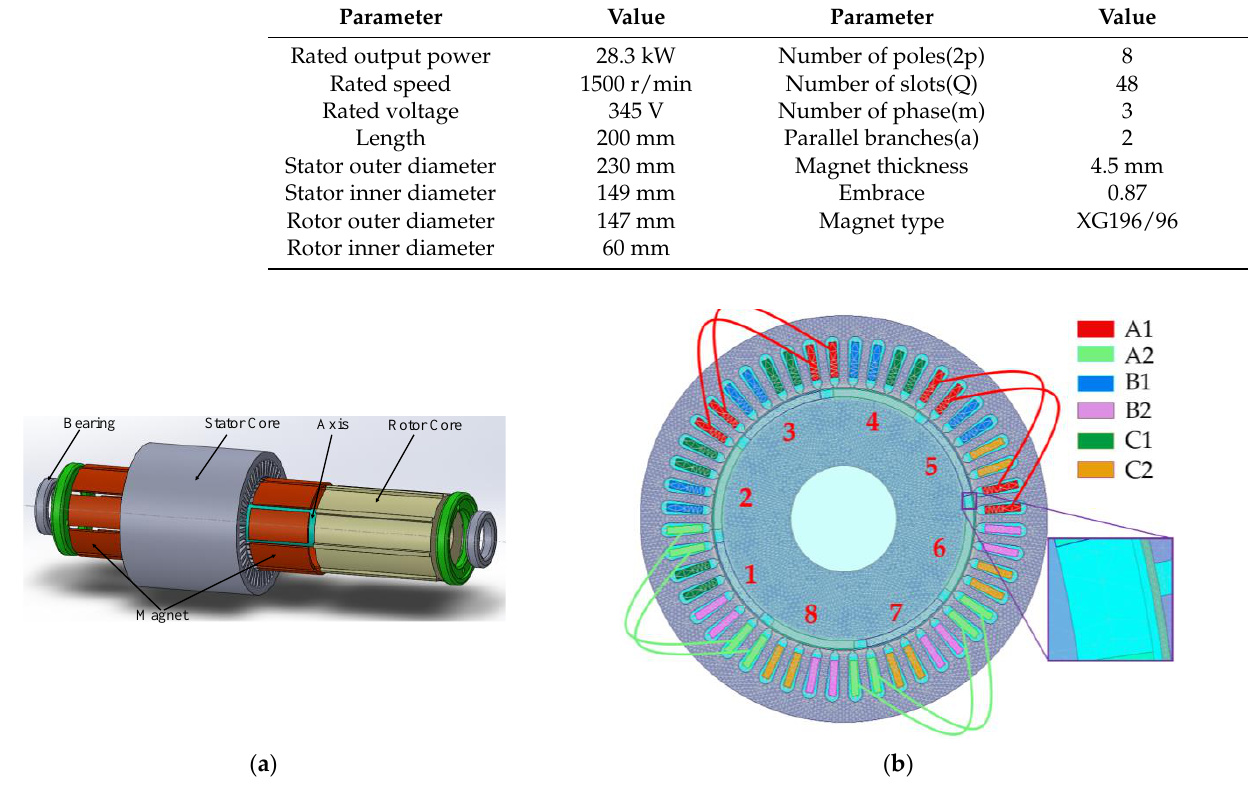
Figure 3. Topology structure of the PMSM. ( a ) Geometric model. ( b ) Winding construction. Table 2. The specific working conditions of the motor settings under various